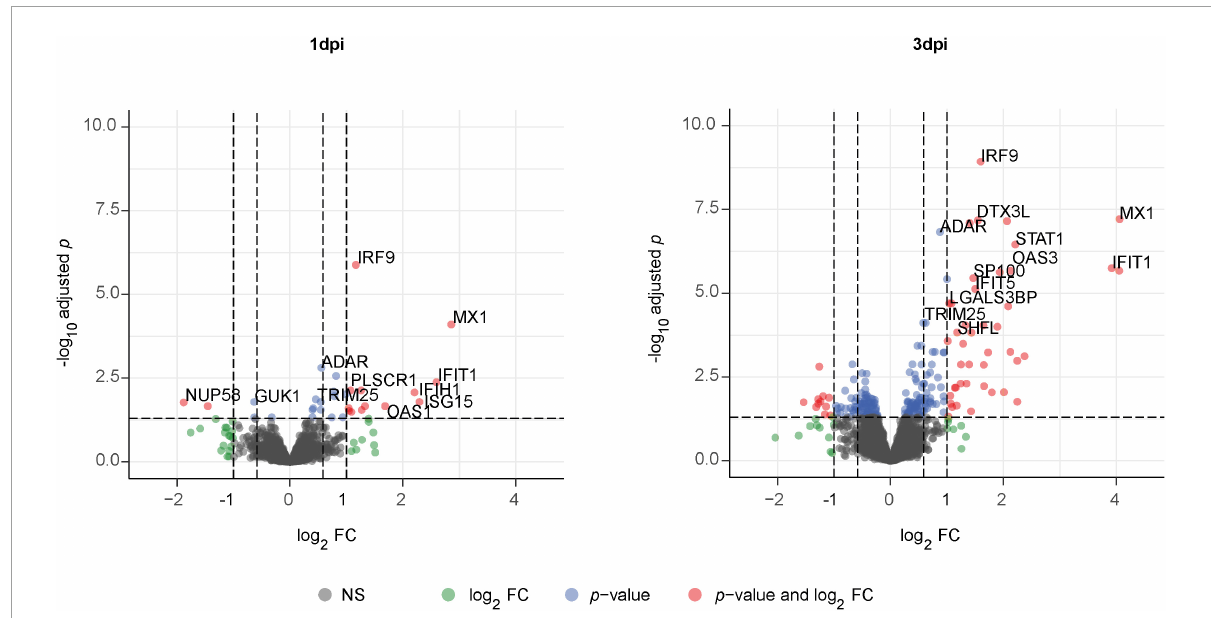
FIGURE3 Volcano plot of significantly altered proteins in fully differentiated primary human bronchial epithelial cells (phBECs) on days 1 and 3 post-influenza virus infection. Fully differentiated phBECs from patients with chronic obstructive pulmonary disease (COPD) ( n = 4) and controls ( n = 3) were either mock-infected or infected with influenza A virus PR8. Cells were harvested for proteomics on days 1 and 3 post-infection (dpi). Volcano plot of significantly altered proteins (PR8/mock) on days 1 (left) and 3 (right) post-infection, independent of the disease state. A protein was considered to be differentially expressed if the comparison resulted in a false discovery rate (FDR) of less than 5% with the Benjamini–Hochberg (BH) correction to correct multiple